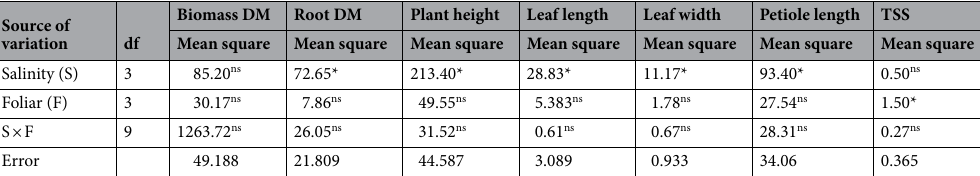
Table 1. ANOVA for the effect of salinity (0, 50, 100, and 150 mM NaCl) and foliar applications (no-foliar, KNO 3 , glucose, and Dobogen) on the root and aerial parts dry weight, plant height, leaf length and width, petiole length, the total soluble solids content of Tanacetum balsamita plants grown hydroponically in perlite. df, degree of freedom; ns, non-significant. *Significant difference at P ≤ 5%, following two-way